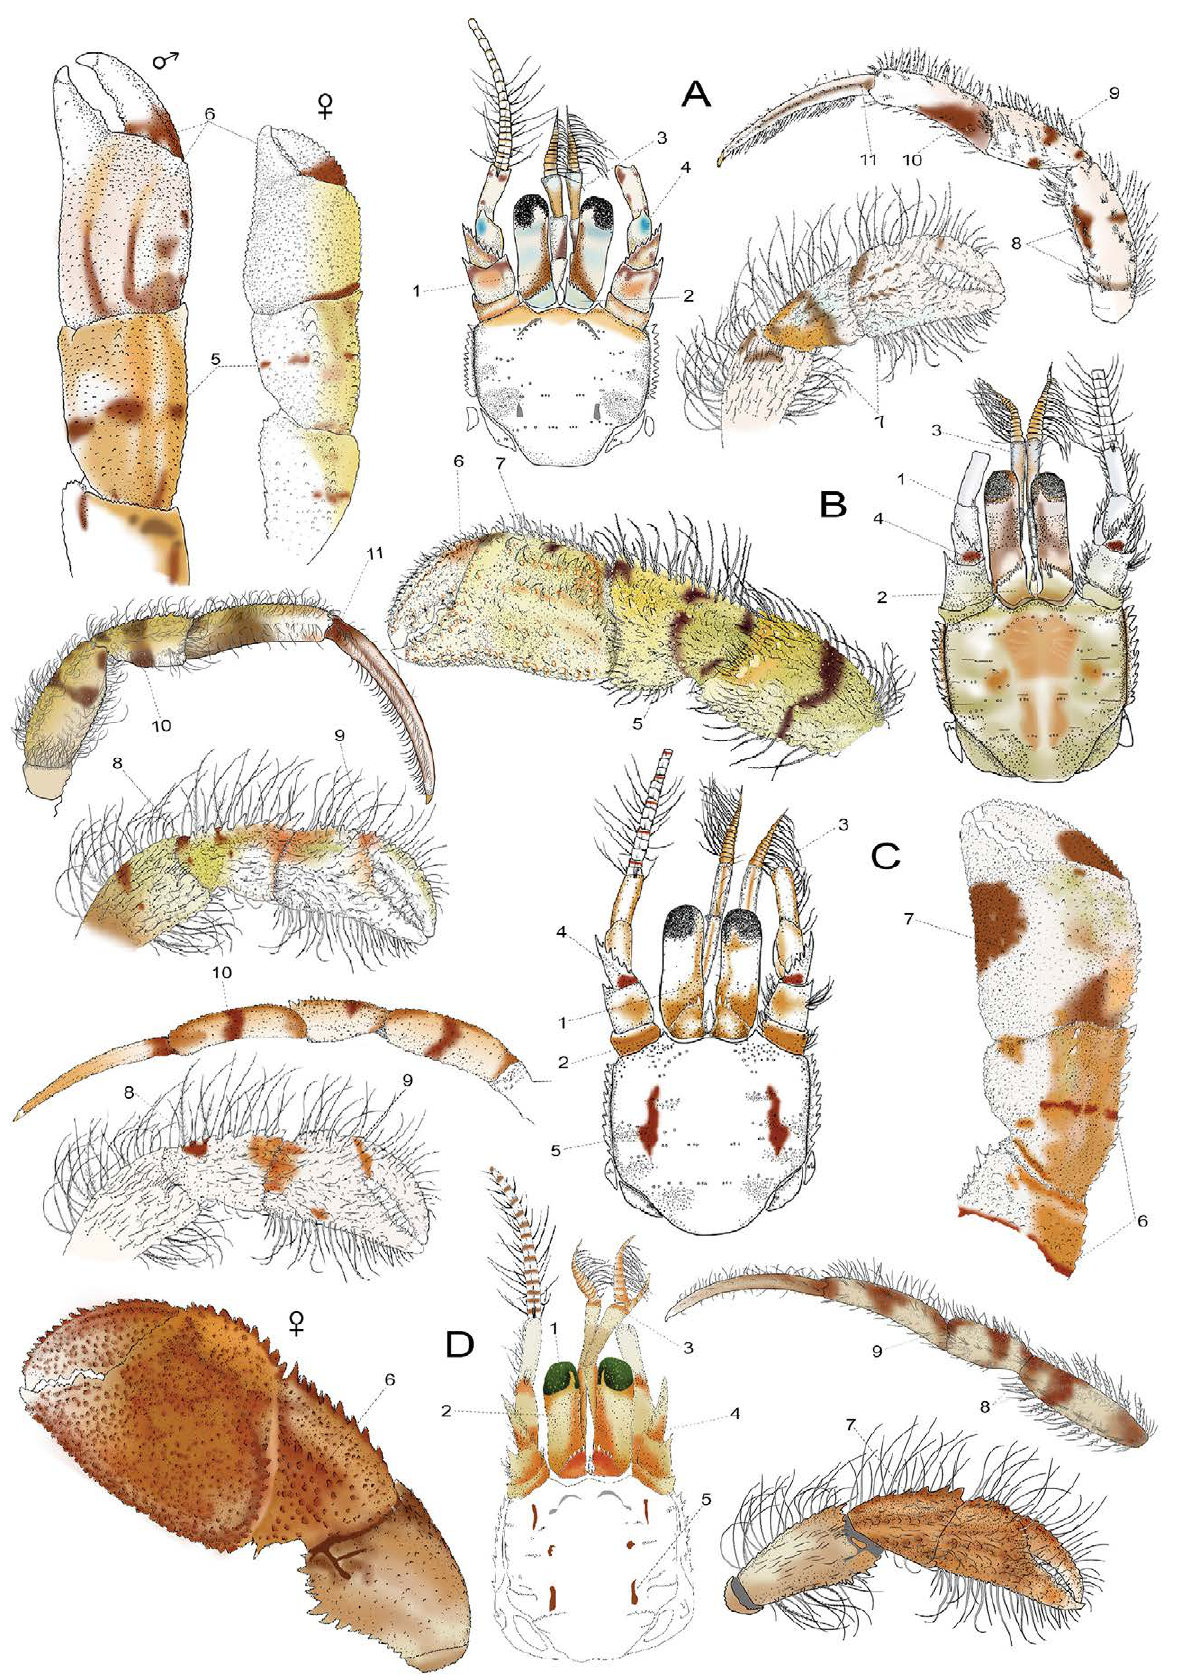
Fig. 2. – Colour patterns of the Diogenidae species: Diogenes curvimanus (A, 1-11); Diogenes armatus (B, 1-11); Diogenes pugilator (C, 1-10); Diogenes erythromanus (D, 1-9). Vectorial drawings are originals from: Almón et al. (2022a,